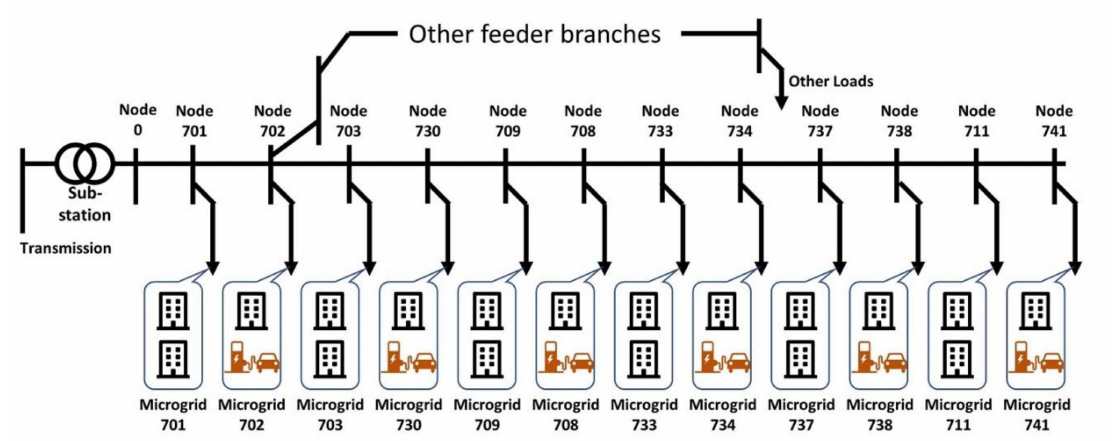
Figure 5. The distribution grid topology in the use case